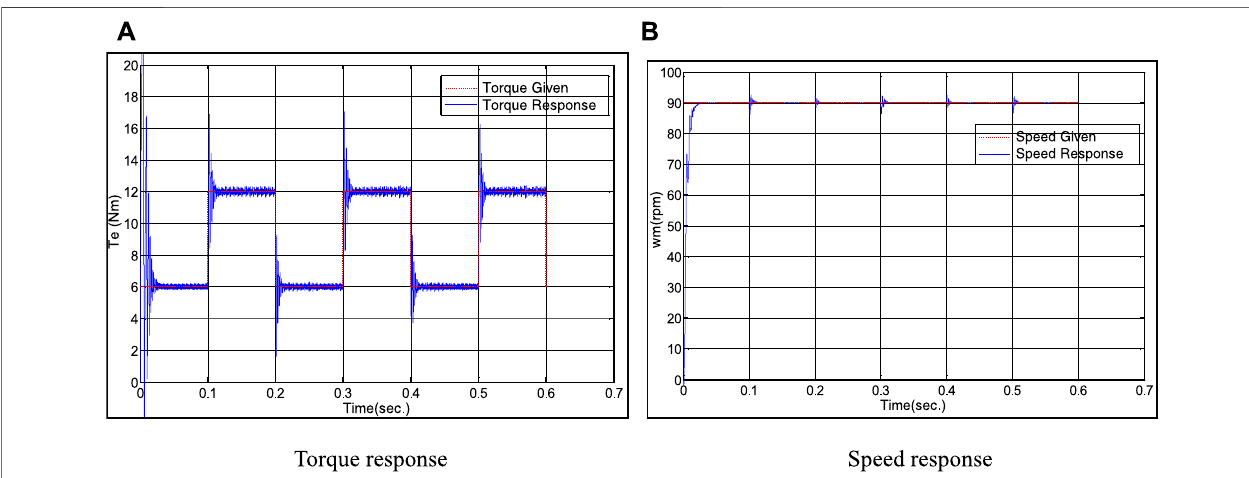
FIGURE 6 | Response curve of BPNN inverse system decoupling control when torque changes periodically.